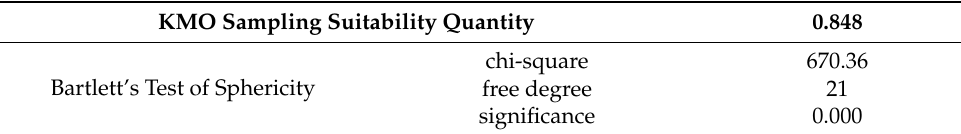
Table A3. KMO and Bartlett Test on Input Index.